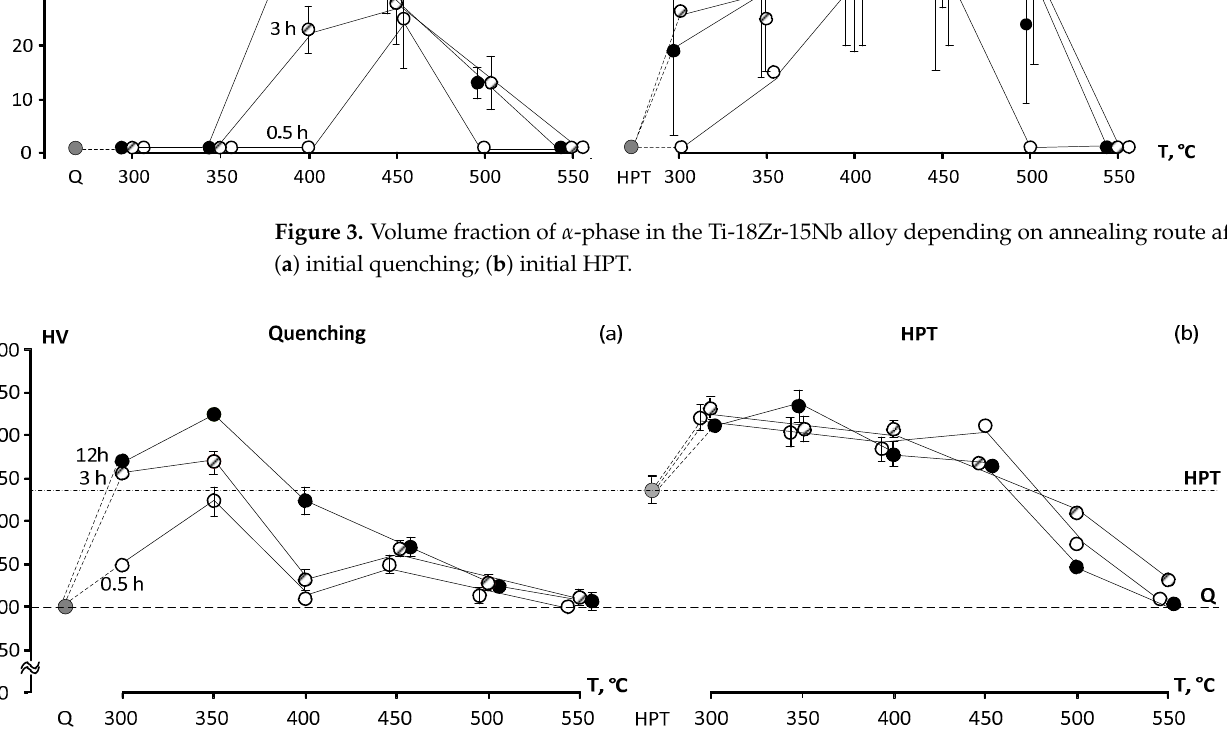
Figure 4. Hardness of the Ti-18Zr-15Nb alloy depending on annealing route after: ( a ) quenching and ( b ) HPT.